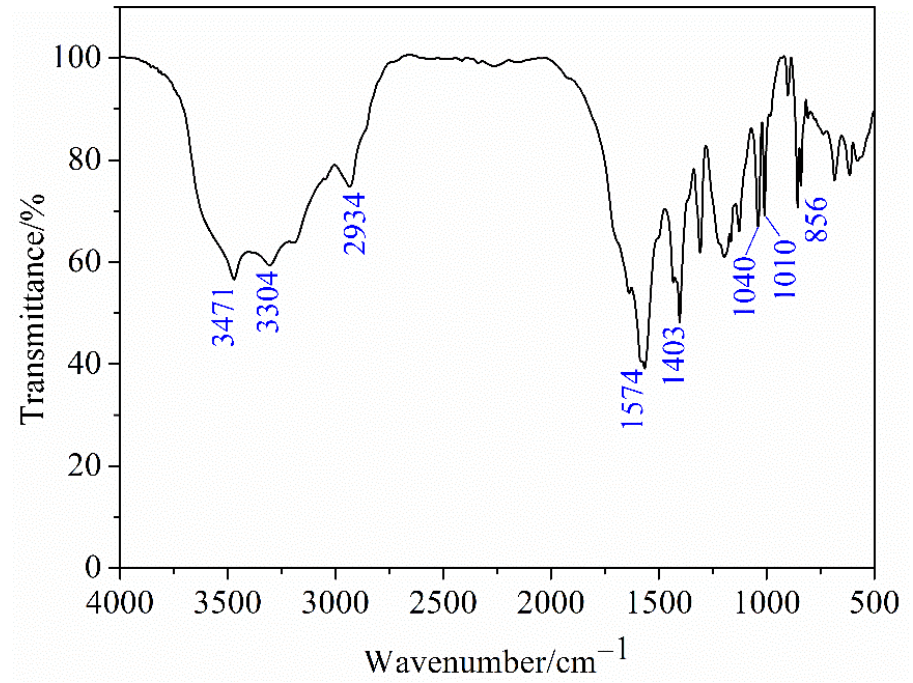
Figure 1. Infrared spectrum of LDMS.